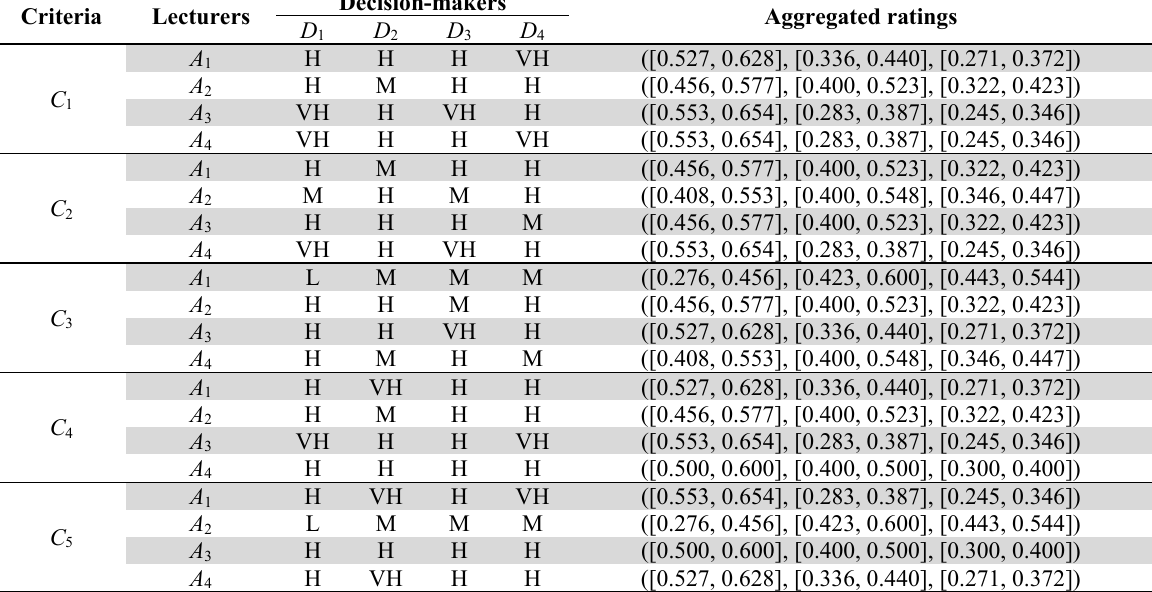
Table 2 Aggregated ratings of lecturers’ research productivity versus the criteria